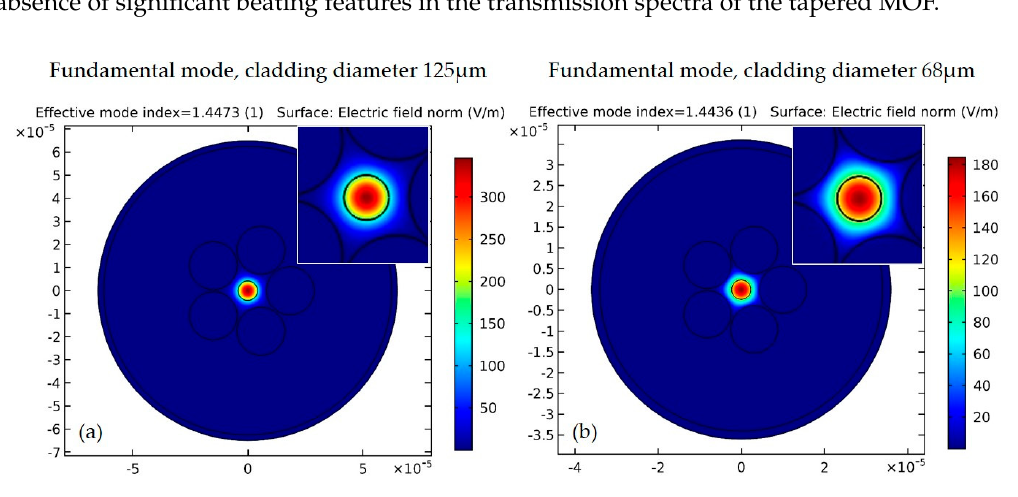
Figure 2. ( a ) Fundamental mode for the MOF in a 2D cross-section image by adopting COMSOL (Multiphysics 3.5, COMSOL Inc., Stockholm, Sweden) simulation. ( b ) Fundamental mode in a 2D cross-section image for a smaller cladding size after the tapering process (68 μ m diameter), and accordingly smaller core and air capillaries. Increased spreading of the mode is observed due to reduced spatial confinement.